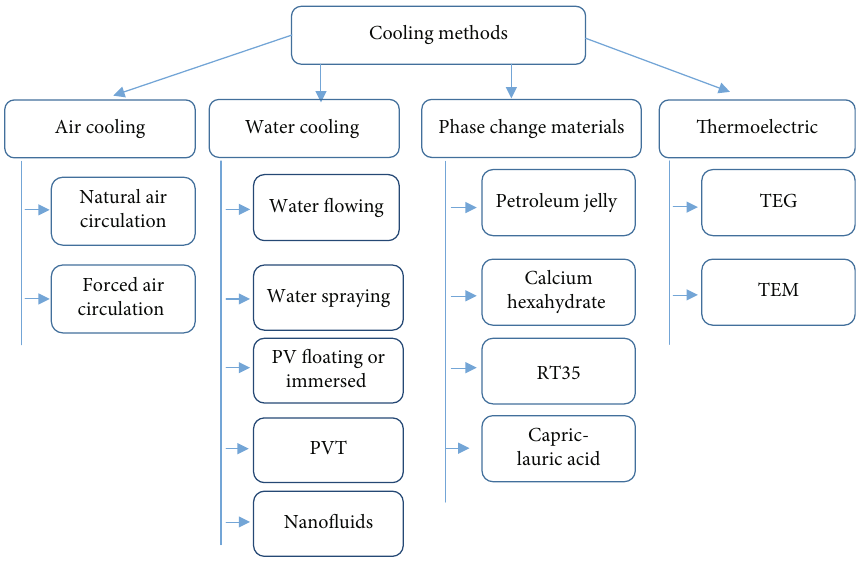
Figure 8: The main cooling